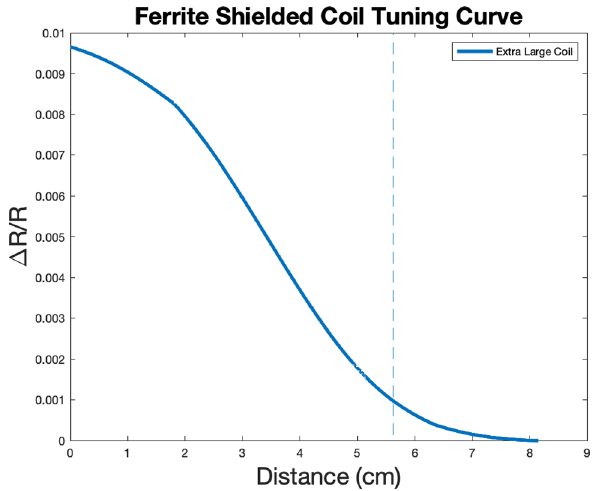
Figure 7. The extra-large coil (24 cm) was explored to confirm that detection depth increases with larger coil implementation. The curve above was produced by moving a 5 cm spherical balloon towards the extra-large coil at a constant rate, starting at a distance of 8 cm and moving closer until the balloon and sensor were touching (0 cm). Maximum sensor range was defined as a 10% change in resistance from baseline ( determined to be the change in signal necessary to overcome noise (SNR = 10). At the point where the signal is 10% of the maximum generated signal, a vertical line is drawn and labeled the distance threshold (the point at which noise is overcome as defined by the SNR, and suggests confidence on signal detection). This coil was found to have a detection depth of 5.63 cm, which is larger than the scanning depths of the large, medium, and small coils